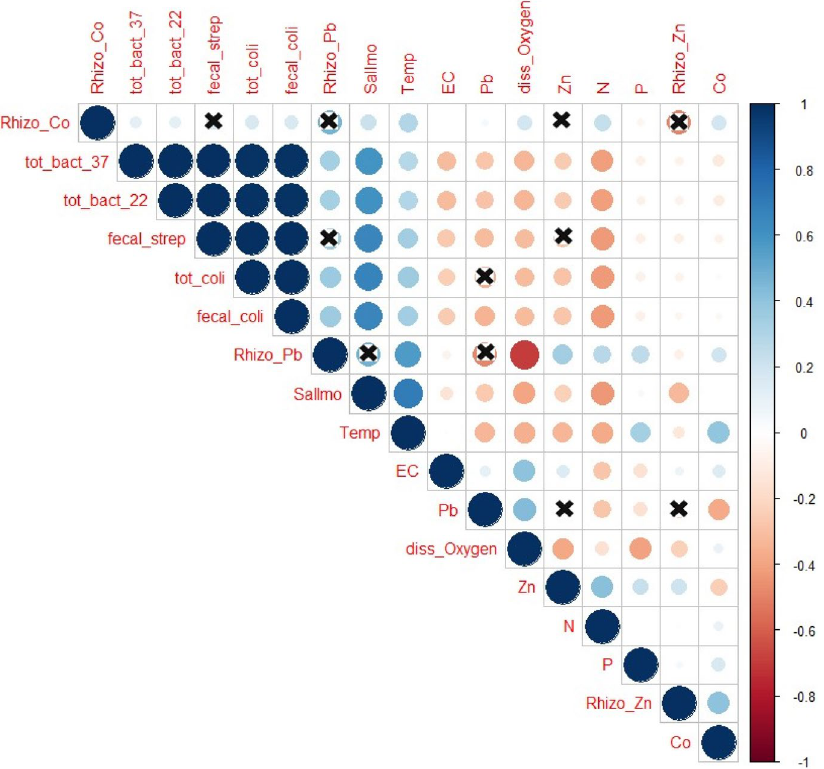
Figure 3. Pearson correlation coefficients (bivariate) between bacterial indicators (TBC at 37 °C and 22 °C for total coliform, fecal coliform, and fecal streptococci), Salmonella spp, P. stratiotes rhizofilteration potential, heavy metals (Pb, Zn, and Co), and physicochemical water properties. The mark “ × ” indicates non-significant correlation ( p >